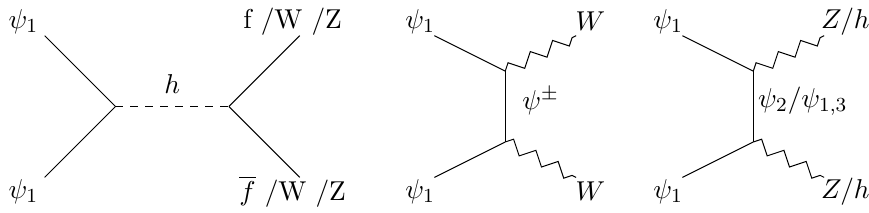
Figure 29. Feynman diagrams for DM annihilation to SM particles for the Fermion DM ( ψ 1